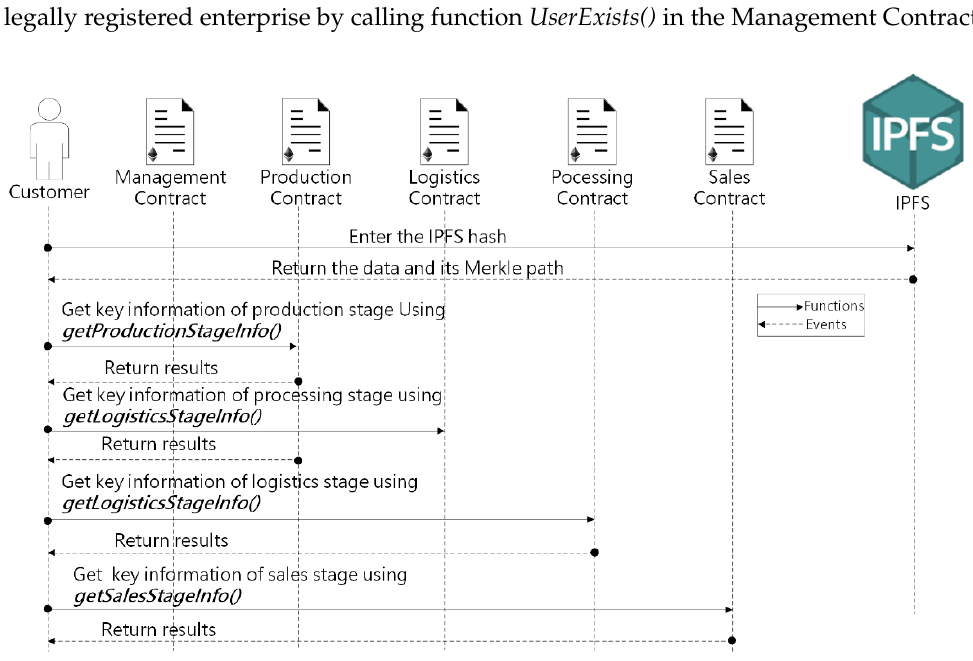
Table 4. The main functions of smart contracts.